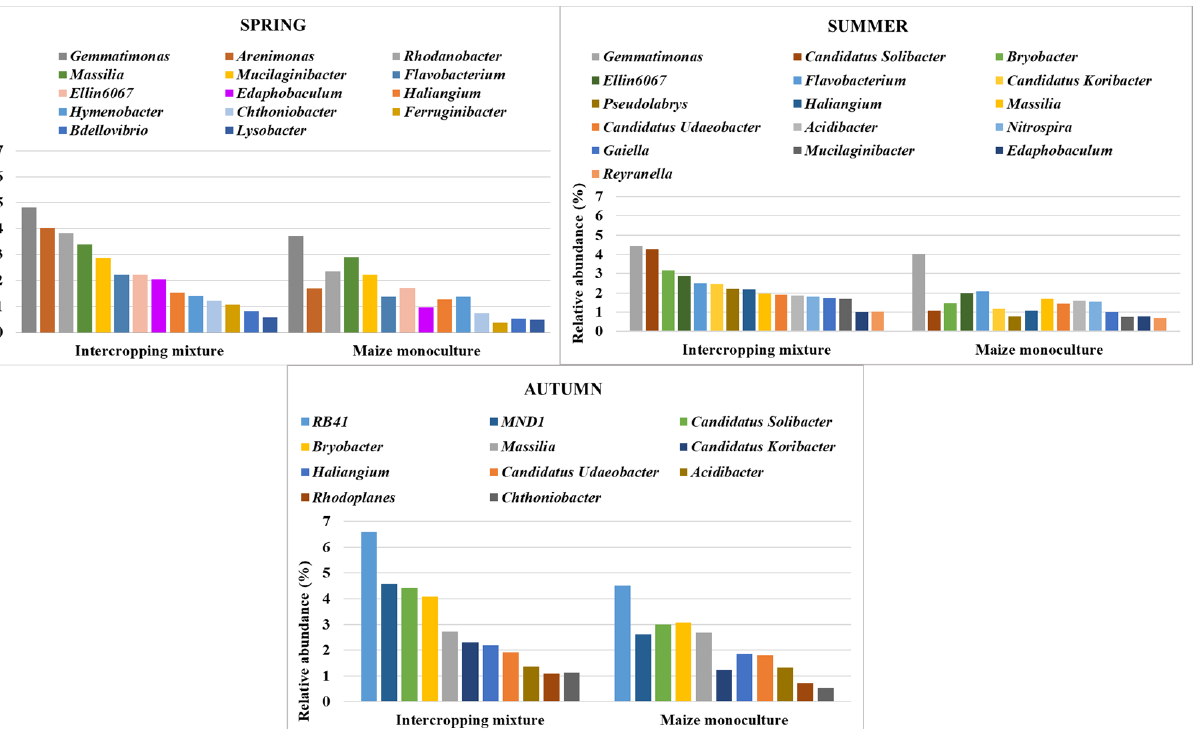
Figure 6. Bacterial genera with sensitivity to the maize monoculture in spring, summer, or autumn .